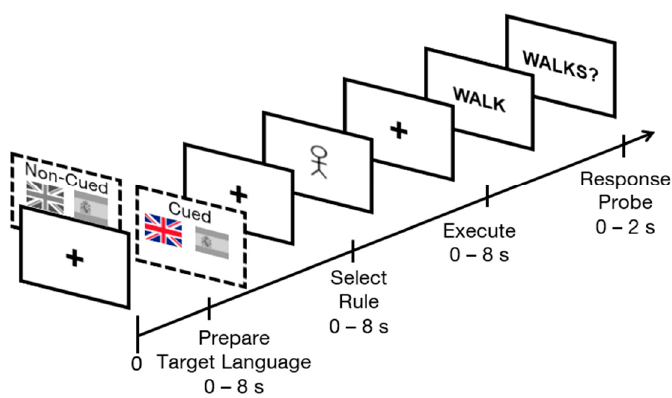
Figure 1. Schematic of sample informative cued and non-informative cued trials in Rapid Instructed Task Learning (RITL) displaying Preparing Target Language, Select Rule, Execute and Response Probe phases. In informative cued trials, one of the two national flags (Great Britain and Spain) is colored, indicating a target language while in non-informative cued trials, both flags are in grey.